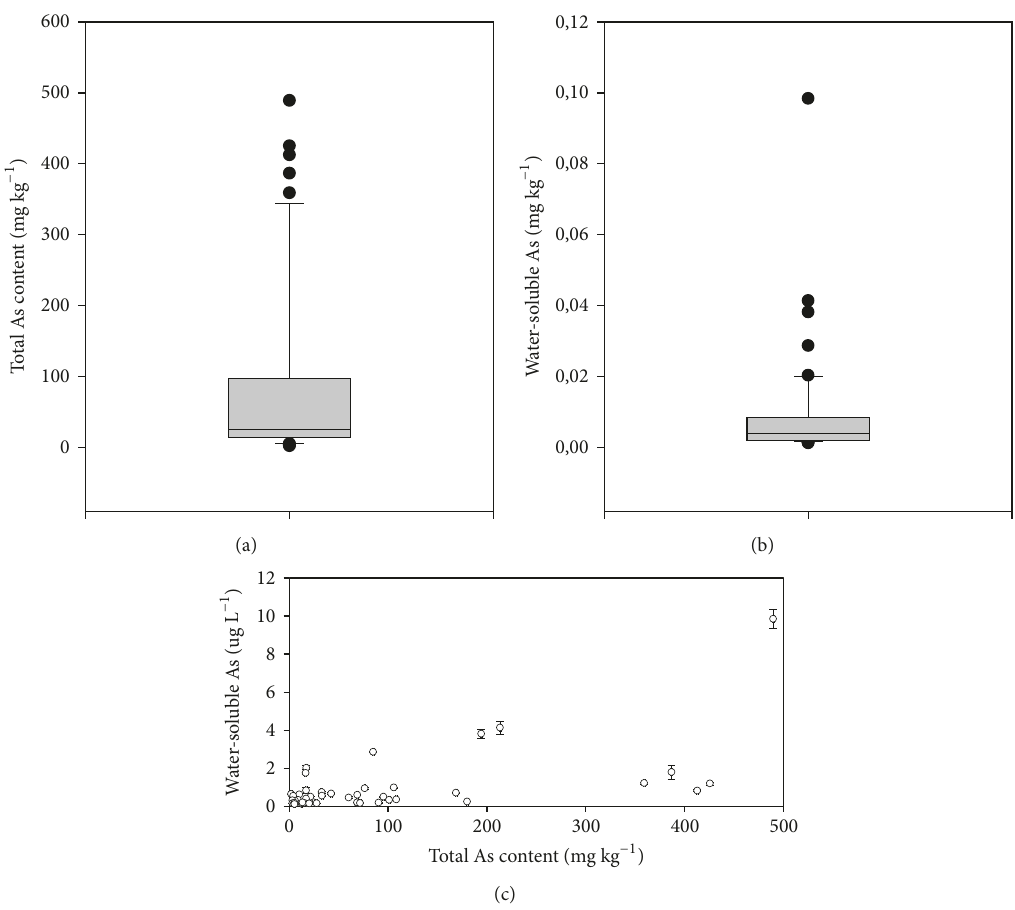
Figure 4: (a) Box plot for pseudo-total As content. (b) Box plot for water-soluble As. (c) Mobilization of water-soluble As in function of pseudo-total As contents in soil samples. The median and 25th and 75th percentiles were represented as lines in vertical boxes, with error bars representing the 10th and 90th percentiles. Table 1. The following decreasing order of abundance of the fractions was observed: F 5 > F 4 ∼ F 6